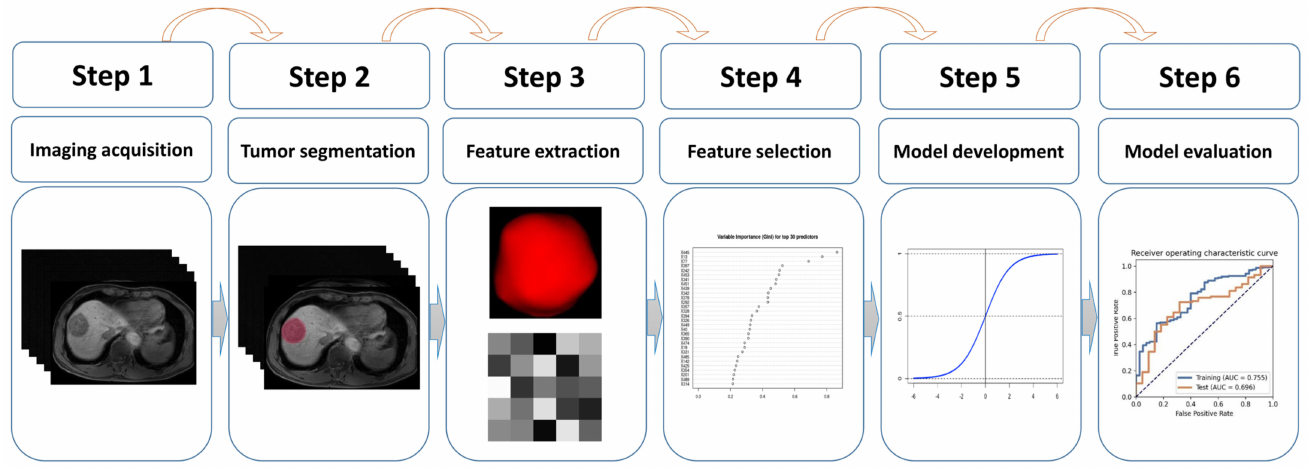
Figure 2. Workflow of the radiomics model development. A typical pipeline of the radiomics model development consists of six steps: imaging acquisition, tumor segmentation, feature extraction, feature selection, radiomics model development, and evaluation of the